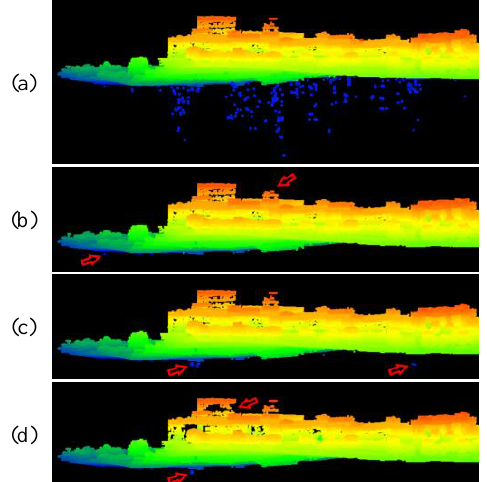
Figure 8. Visual comparison of results, (a) original data, (b) CH, (c) SF, and (d) SOR filter